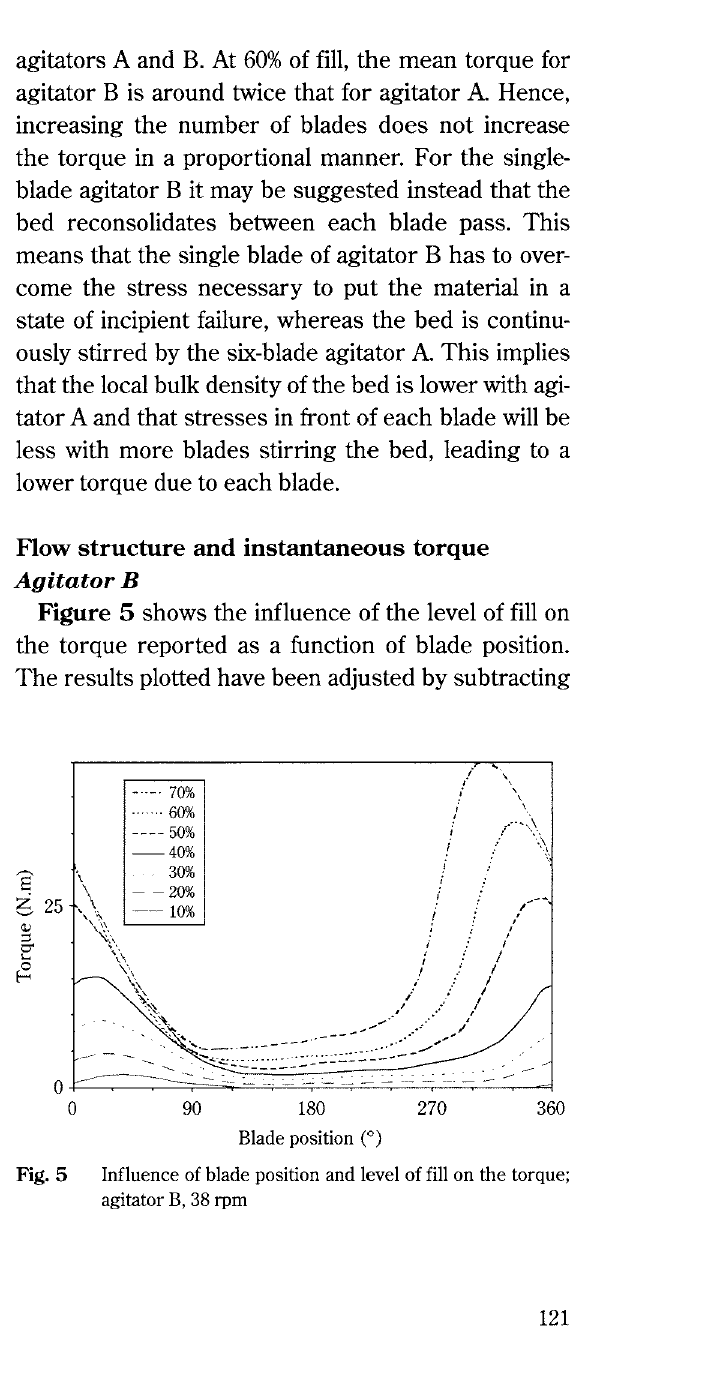
Fig. 4 Mean torque vs. circumferential length:£, agitators A and B; 38rpm